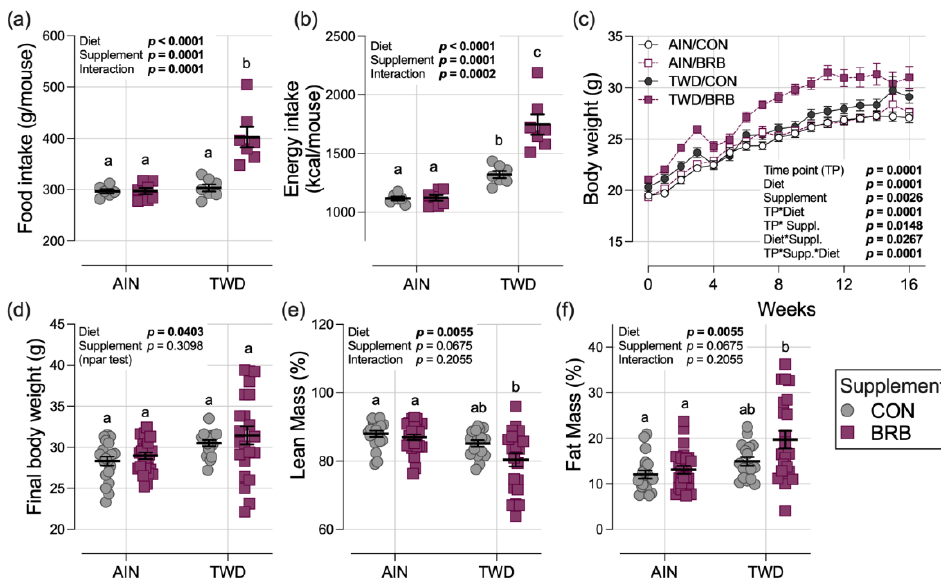
Figure 3. Food and energy intakes, body weight and body composition (experiment B). ( a , b ) Esti- mated total daily food and energy intake per mouse. See Figure S7 for longitudinal food and energy intake data. ( c ) Body weight gain over the study period. ( d ) Final body weight at study end on day 115. ( e , f ) Lean and fat mass as percentage of body weight. Data are shown as the individual meas- urements (except ( c )) with the mean ± SE ( a , b , d – f ). Inset tables show the statistical model main ef- fects for diet, treatment and their interaction or “npar test” if a non-parametric test was required, and different letters indicate that experimental groups are significantly different ( p < 0.05), as deter- mined by statistical methods outlined in Materials and Methods.